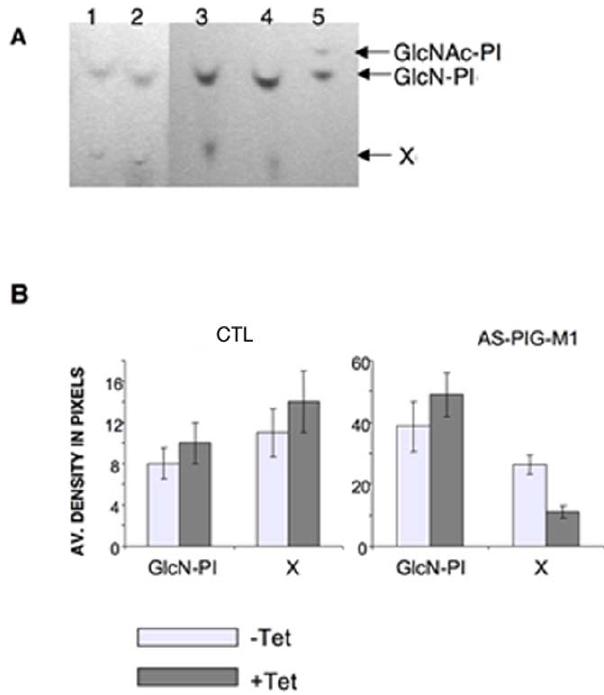
Figure 3. GPI-intermediate biosynthesis with extracts from EhPIG-M1 antisense blocked cells. Crude membrane preparation from tetracycline induced and uninduced trophozoites were labeled with [14]-C UDP-N-acetylglucosamine in a cell free system in the presence of GDP-mannose. GPI biosynthesis intermediates were isolated and analyzed by HPTLC and visualized by fluorography. Panel A, Lane 1-2: GPIs from untreated and tetracycline treated vector control respectively, lane 3-4, GPIs from untreated and tetracycline treated EhPIG-M1 antisense cells line respectively; lane 5 shows the first two intermediates of the GPI-pathway, namely GlcNAc-PI and GlcN-PI, as control. Panel B shows the densitometric analysis of the radiolabeled products as obtained on HPTLC chromatography, I- GlcN-PI and product X for untreated (clear boxes) and tetracycline treated (black boxes) cells carrying the control vector (CTL), or the EhPIG-M1 antisense construct. An increased level of GlcN-PI (the substrate of PIG-M) is observed in extract carrying reduced levels of